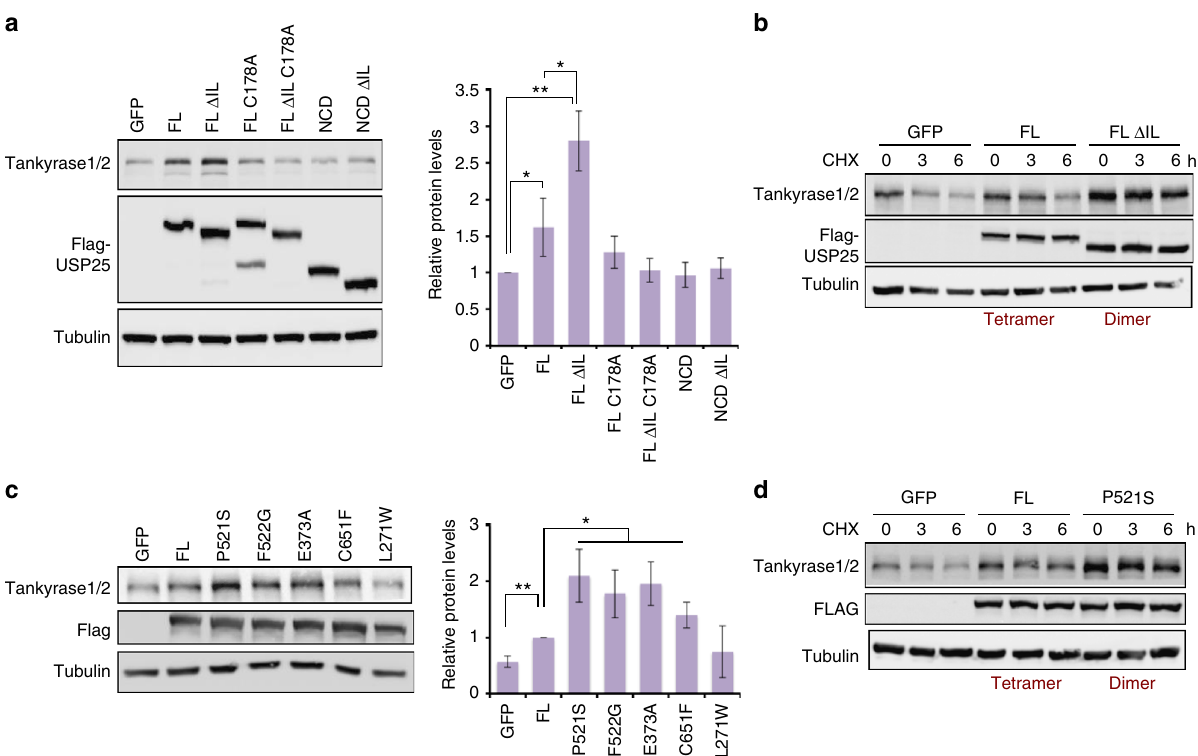
Fig. 6 The USP25 dimer stabilizes endogenous tankyrase in HEK293T cells. a Flag-USP25FL, Flag-USP25FL Δ IL, Flag-USP25FL C178A, Flag-USP25FL Δ IL C178A, Flag-USP25NCD, and Flag-USP25NCD Δ IL were transfected in HEK293T cells and the levels of endogenous tankyrases1/2 were analyzed by western blot (WB). GFP was transfected as a control. Plot of the quanti fi cation of tankyrase1/2 levels, corrected with tubulin and relative to GFP. Data values are mean ± s.d. and n ≥ 3 technical replicates. Signi fi cance was measured by a two-tailed unpaired t test for all lanes relative to GFP and between USP25FL and USP25FL Δ IL. * P < 0.05, ** P < 0.01. b HEK293T cells were transfected with Flag-USP25FL, Flag-USP25FL Δ IL, and GFP and cells were treated